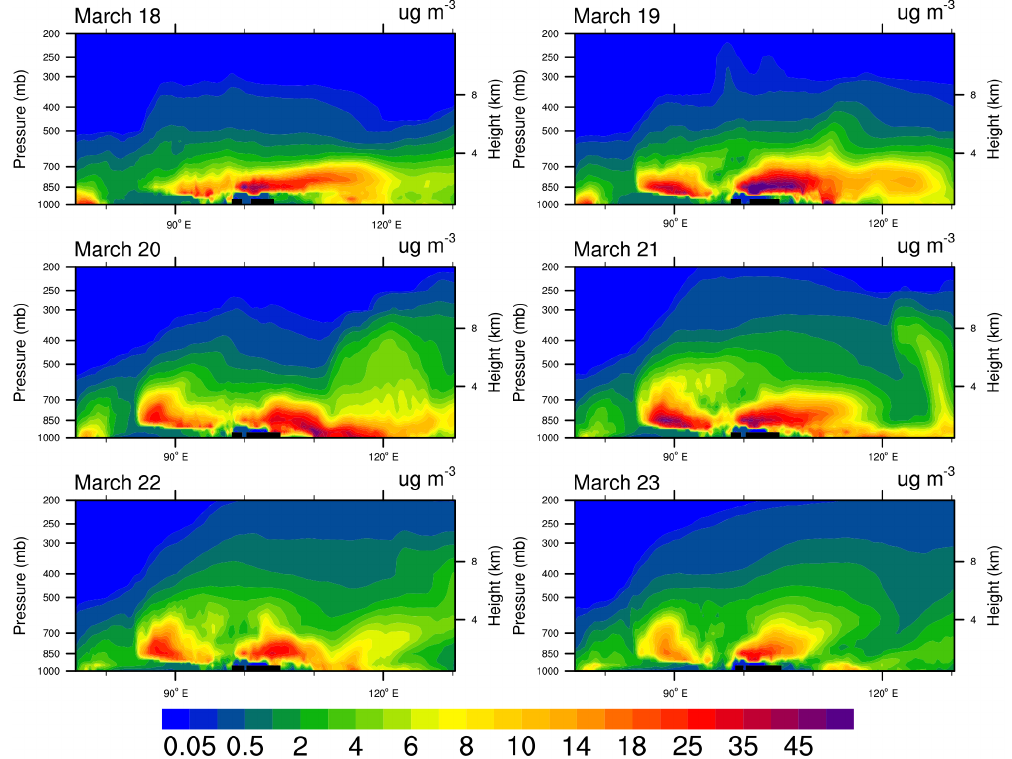
Figure 10. Temporal and spatial cross sections of the meridional mean PM 2 . 5 dust concentration (µgm − 3 ) in the domain simulated by the WRF-Chem model during the simulation